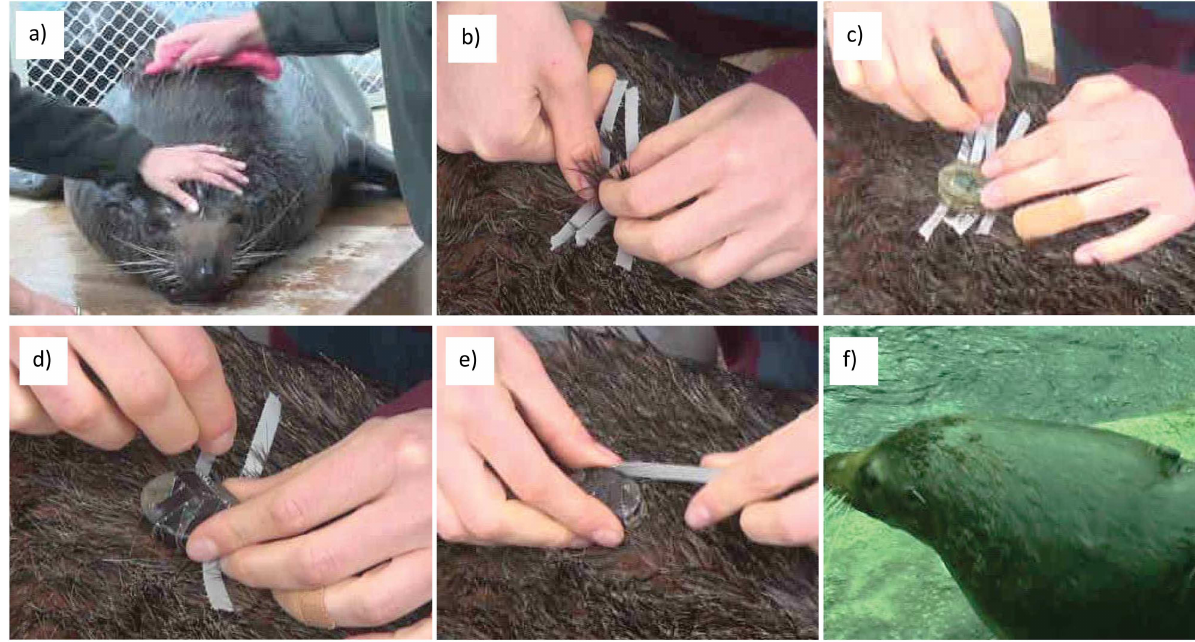
Fig 1. Process of accelerometer attachment with tape. a) Dry the fur; b) Lift the hair to stick tape to undercoat; c-e) Tape on the accelerometer; f) Seal with